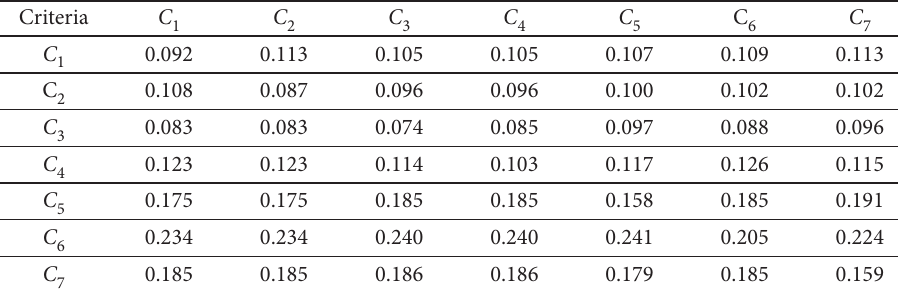
Table B7. DEMATEL-weighted super-matrix W DW